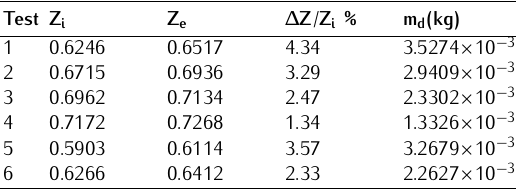
Table 6. Initial and final compressibility factor during experiments.